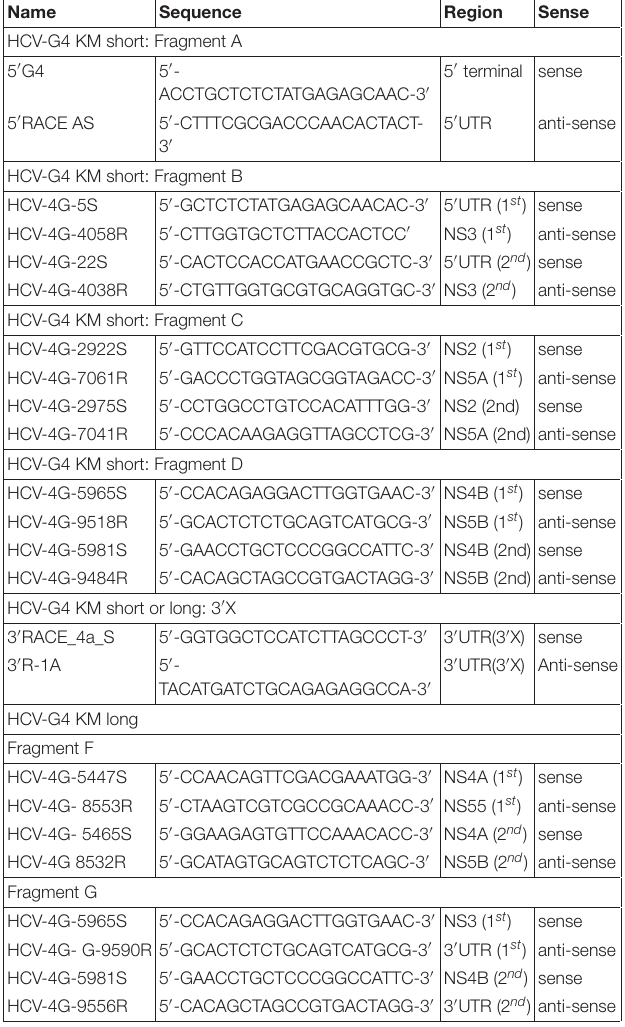
TABLE 1 | Primers used to clone HCV genotype